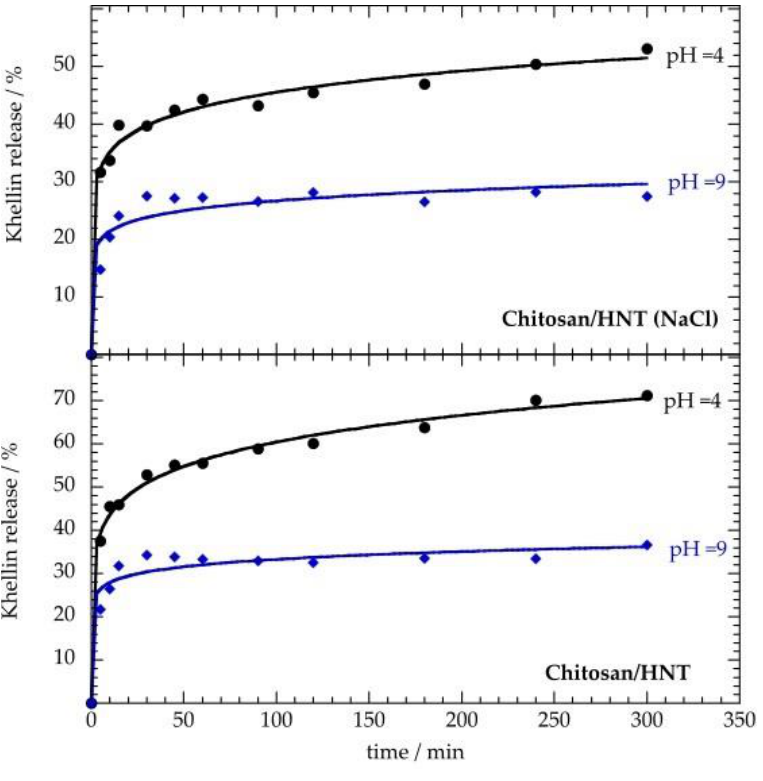
Figure 5. Khellin release as a function of time in water under acidic (pH = 4) and basic (pH = 9) conditions. Solid lines represent the fitting according to the Korsmeyer–Peppas model (Equation (5)). Table 5. Fitting parameters for khellin release under acidic (pH = 4) and basic (pH = 9) conditions. Nanocarrier pH k / min −